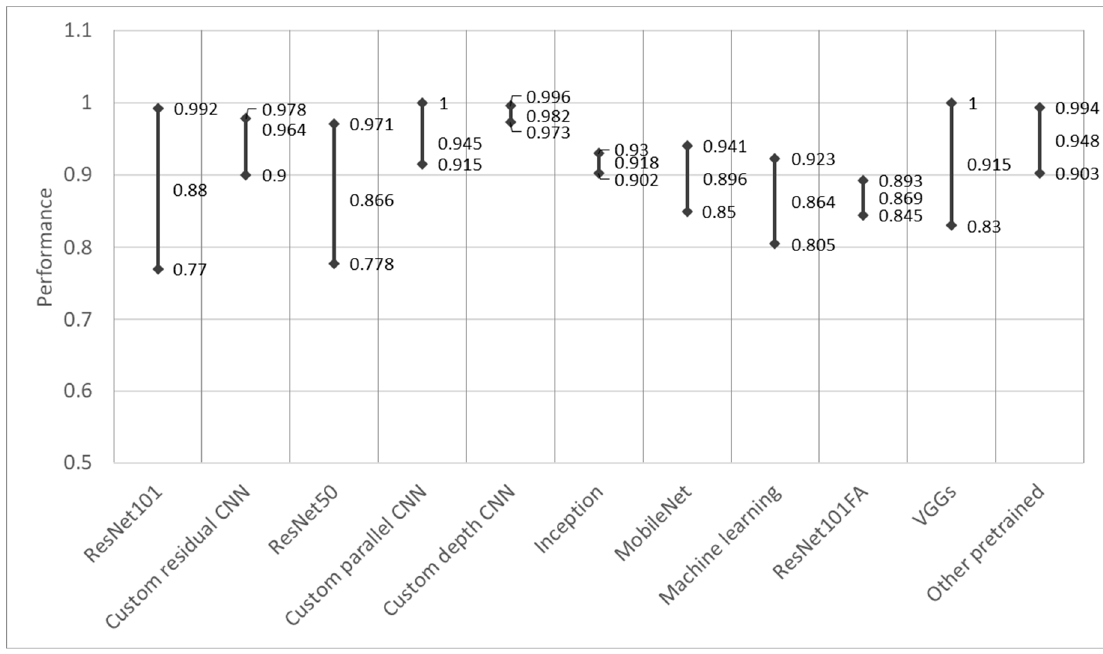
Figure 9. Backbone performance evaluation.